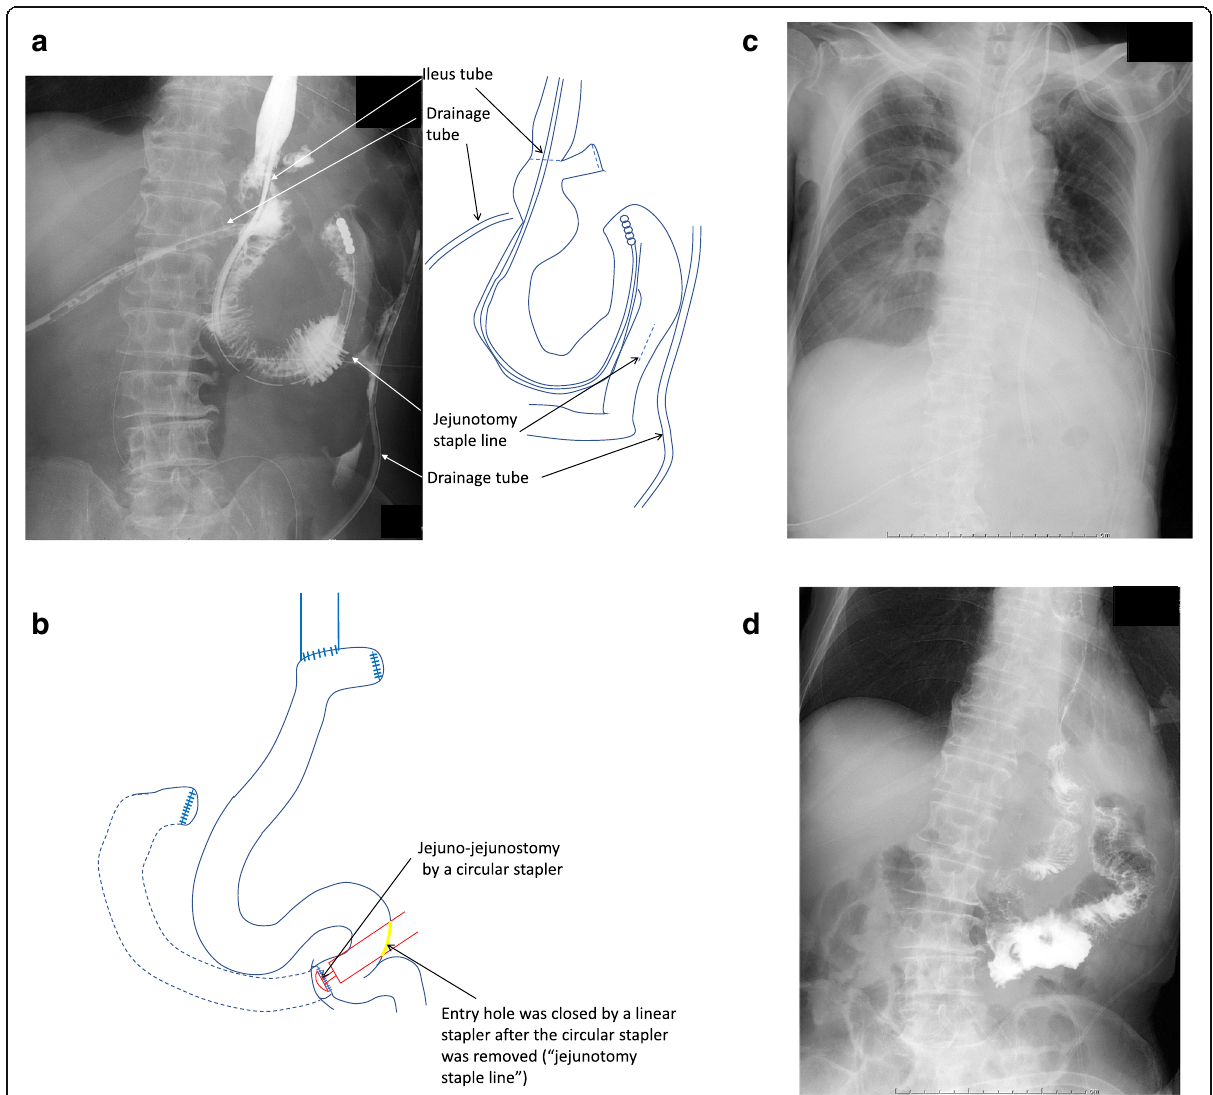
Fig. 2 Case 1. a The contrast medium leaked through the drainage tubes into the esophagojejunostomy and the jejunotomy staple line (arrows). b The scheme shows jejunojejunal anastomosis with a circular stapler. We made an incision at the side of the elemental limb, inserted circular stapler, and anastomosed end to side; the jejunotomy staple line was made for closing the entry hole. c We inserted a 14-Fr catheter into the jejunal limb with side holes by esophagojejunostomy. d The contrast study shows that leakage stopped after effective inner